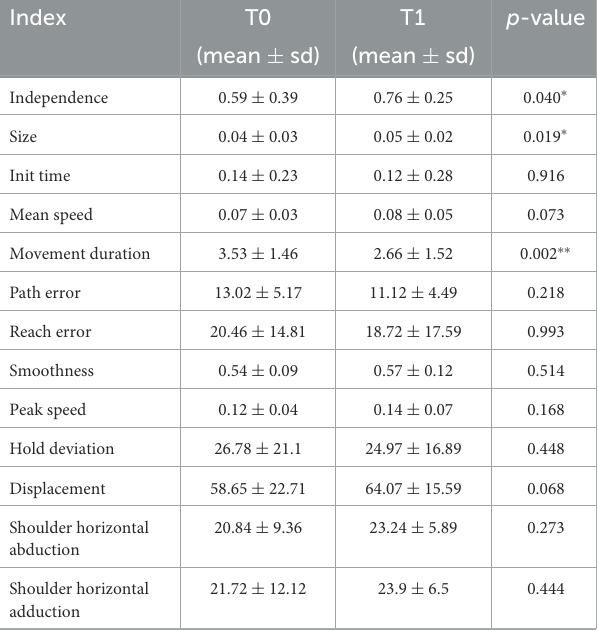
TABLE 3 Comparison between T0 and T1 for iCONE